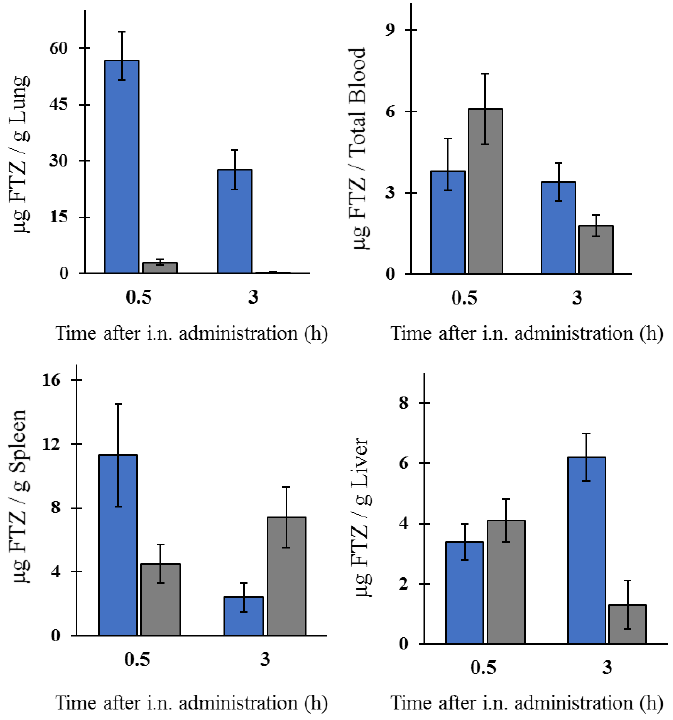
Figure 5. Biodistribution profile of FTZ in the free form (grey columns) or incorporated in liposomes (blue columns) after i.n. administration. FTZ levels in lung, blood, spleen, and liver. The obtained results are expressed as a mean ± SD of three animals per analyzed time and formulation. Mice received the formulation and were sacrificed 0.5 or 3 h after i.n. administration. The obtained results are expressed as mean ± SD ( n = three mice per selected time and per FTZ formulation).